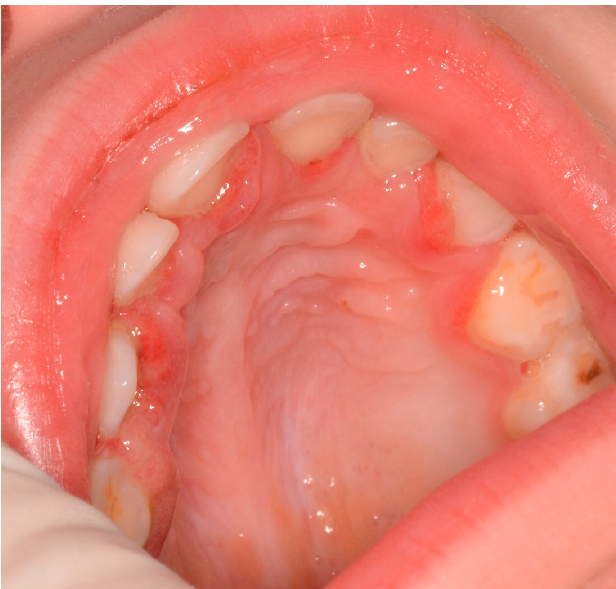
Figure 3. Oral tissues healing presentation after four weeks of Vitamin C administration (Tf).